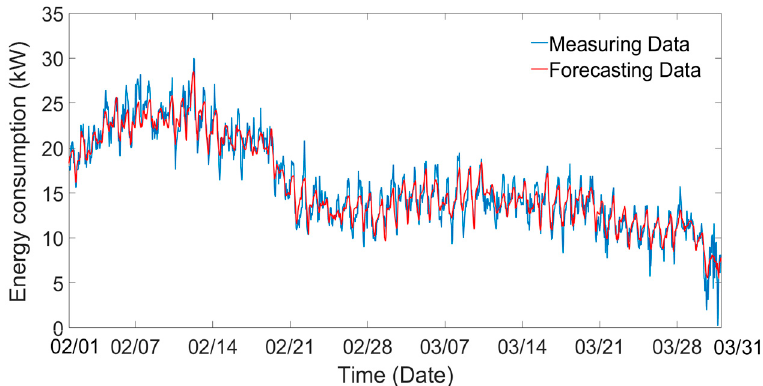
Figure 4. Comparison of forecast and measured heat consumption by ANN from 1 February 2021 to 31 March 2021.